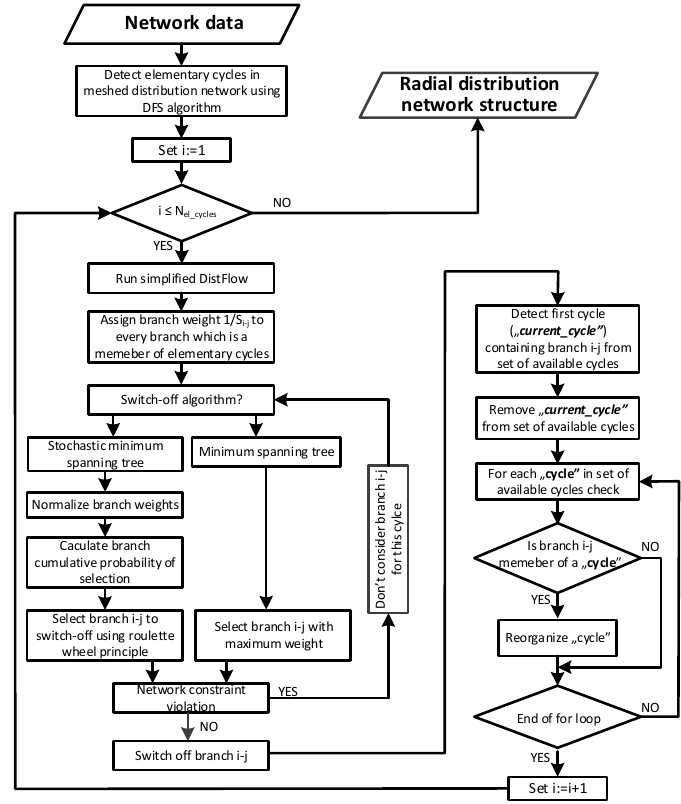
Figure 3. General framework for TD and BU cycle break algorithms.